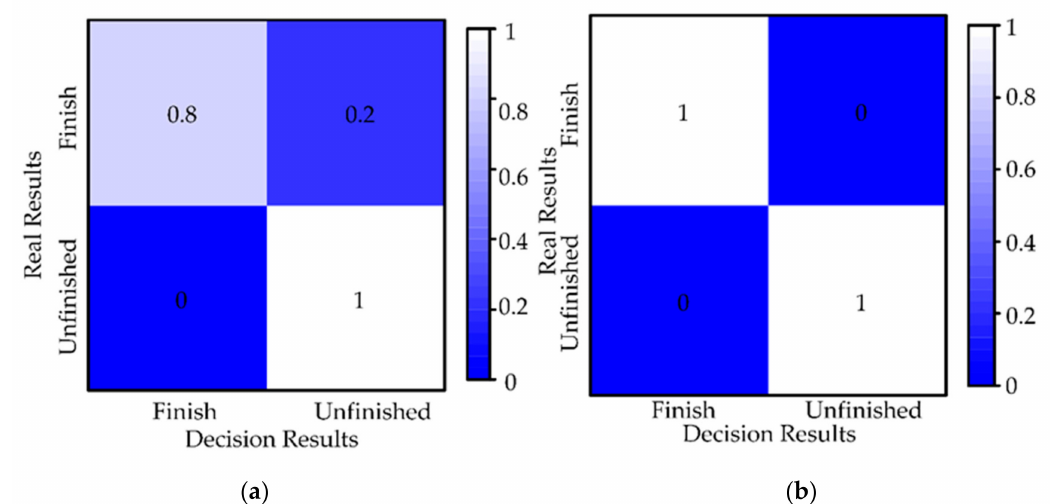
Figure 18. Confusion matrix for fusing decision results. ( a ) operation tool 1 and operation object 1, ( b ) operation tool 2 and operation object 2.